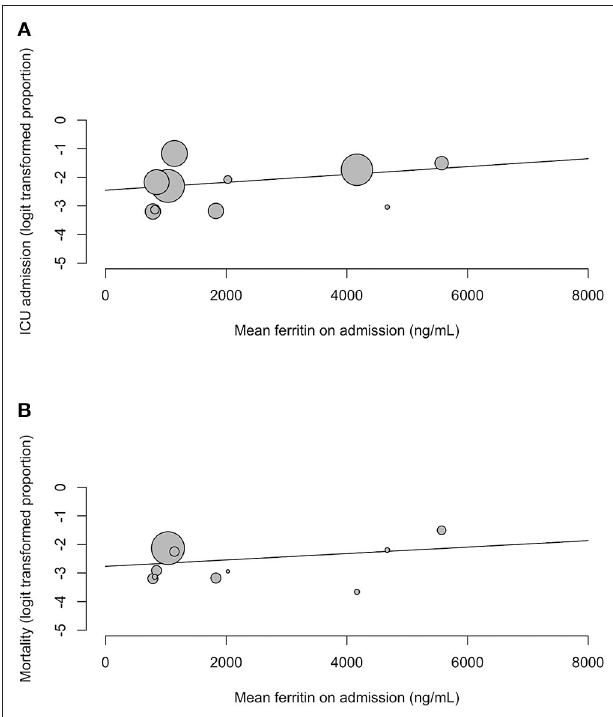
FIGURE 4 | Meta-regression bubble plots for (A) ICU admission and (B) mortality against mean serum ferritin on